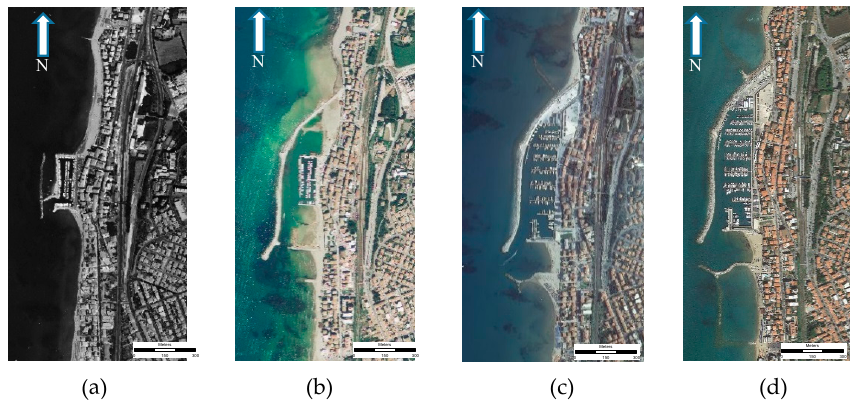
Figure 5. Harbor area in the periods: ( a ) 1994; ( b ) 2006, ( c ) 2012. Source: Geoportale nazionale [43] ( d ) 2019, source: Landsat 8 Satellite.